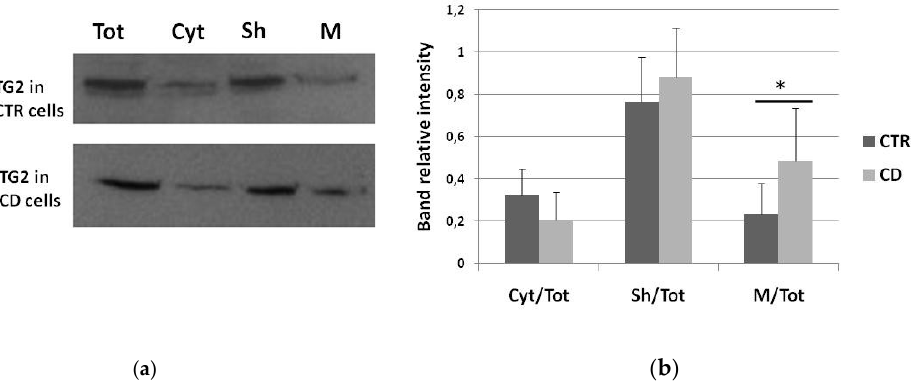
Figure 2. TG2 subcellular distribution in cytosolic and membrane fractions. ( a ) Western blot anti-TG2 on total lysates and on cytosolic and membrane fractions of fibroblasts from one representative control subject and one representative celiac subject (Tot, total lysate; Cyt, cytosol; Sh, sheets; M, membrane). ( b ) Graphical representation of mean values (and standard deviations ) of densitometric analyses of relative TG2 levels into each fraction, expressed as the ratio between band intensity of the fraction and band intensity of the respective total lysate. The graph is relative to Western blots performed on four control samples and four CD samples. Asterisk (*) indicates that p is < 0.05.